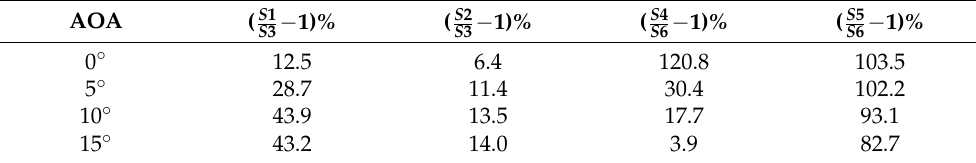
Table 2. Relative pressure differential readings at 9 m/s and angle of attack between 0 ◦ and 15 ◦